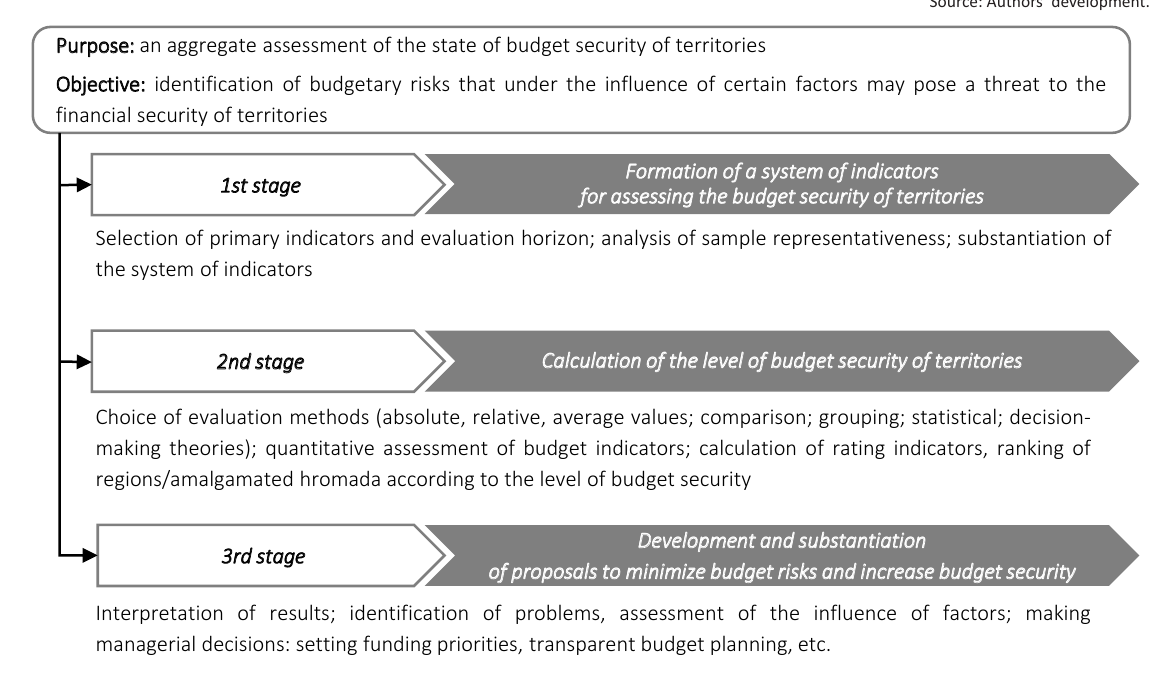
Figure 1. Stages of assessing the budgetary security of Table 1. System of indicators for assessing the budgetary security of territories